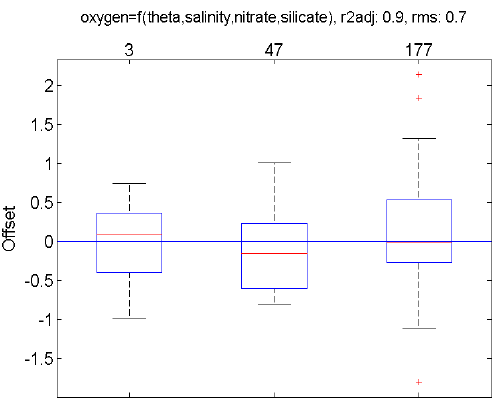
Figure 8. MLR results for O 2 in the Makarov Basin (o ff sets in µ molkg − 1 ).